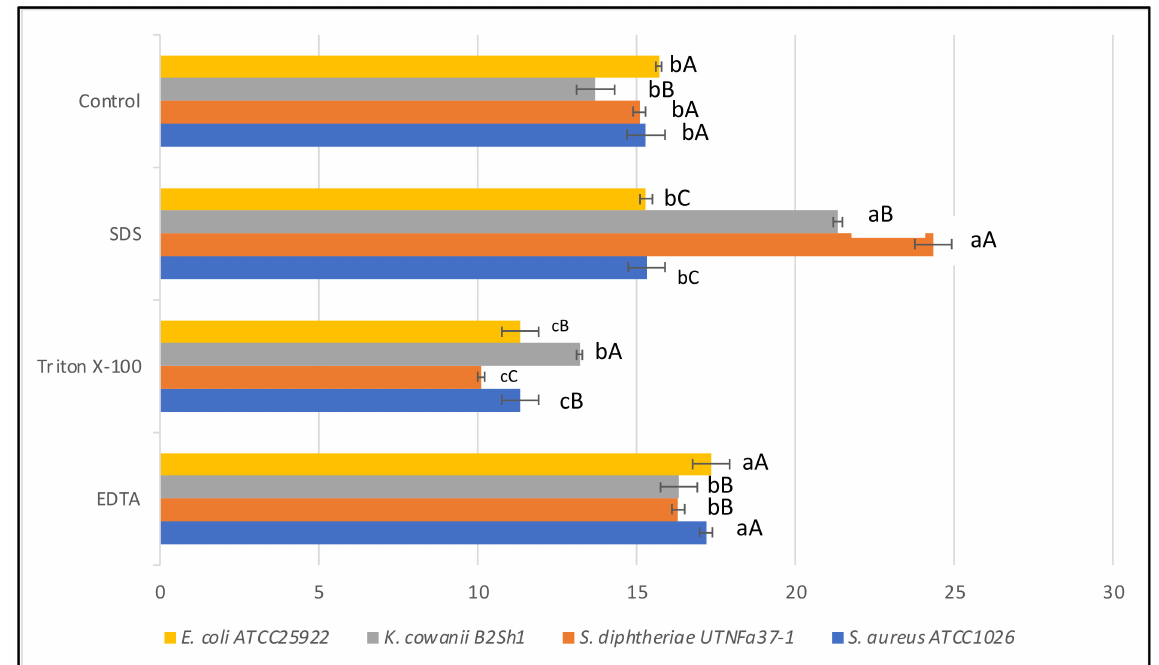
Figure 6. Effect of EDTA, Triton-X100, SDS on antimicrobial activity of CE obtained from Fa17.2. Diameter of the inhibition zone (mm) is shown. Bars are the means ± standard error. Values with different letters are significantly different p < 0.05. Small letters show the difference between treatment- pathogen and control (LSD with Bonferroni correction); capital letters indicate the differences within pathogen (Duncan’s test). Table 2. Antimicrobial activity (inhibition zone expressed in mm) of the CE at different pH against indicator